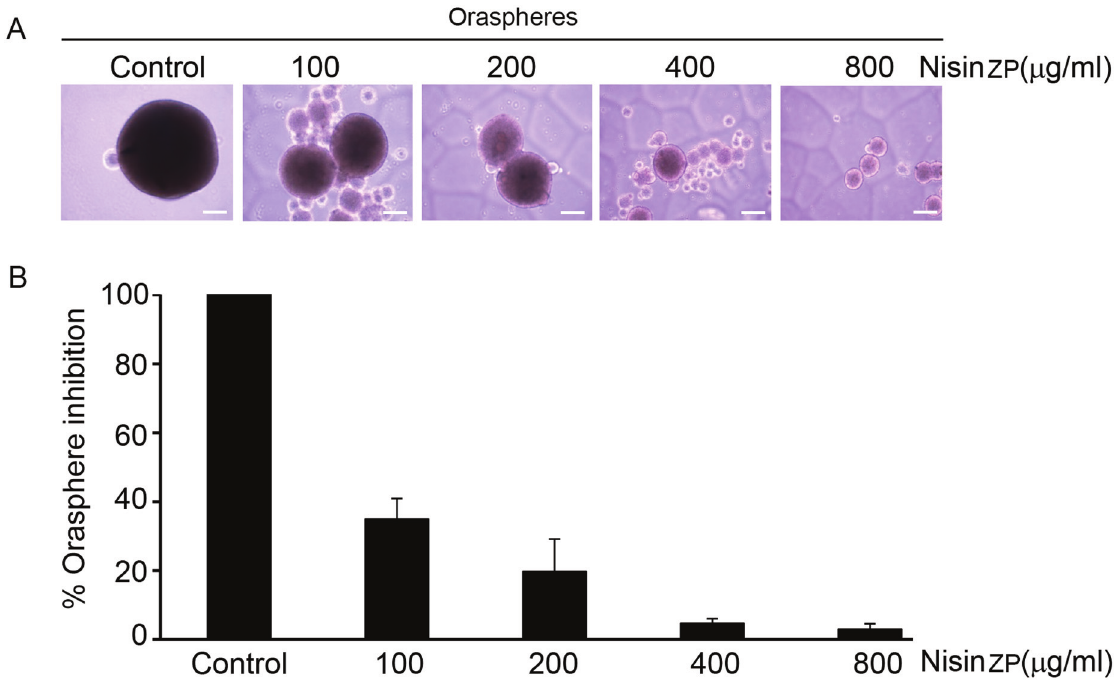
Fig 4. Nisin ZP inhibits orasphere formation in HNSCC cells. A , Phase contrast images and B , graph showing percentage of orasphere inhibition (total area) in HNSCC cells (UM-SCC-17B) cultured under suspension conditions and treated with control media or media containing nisin ZP (100 to 800 μ